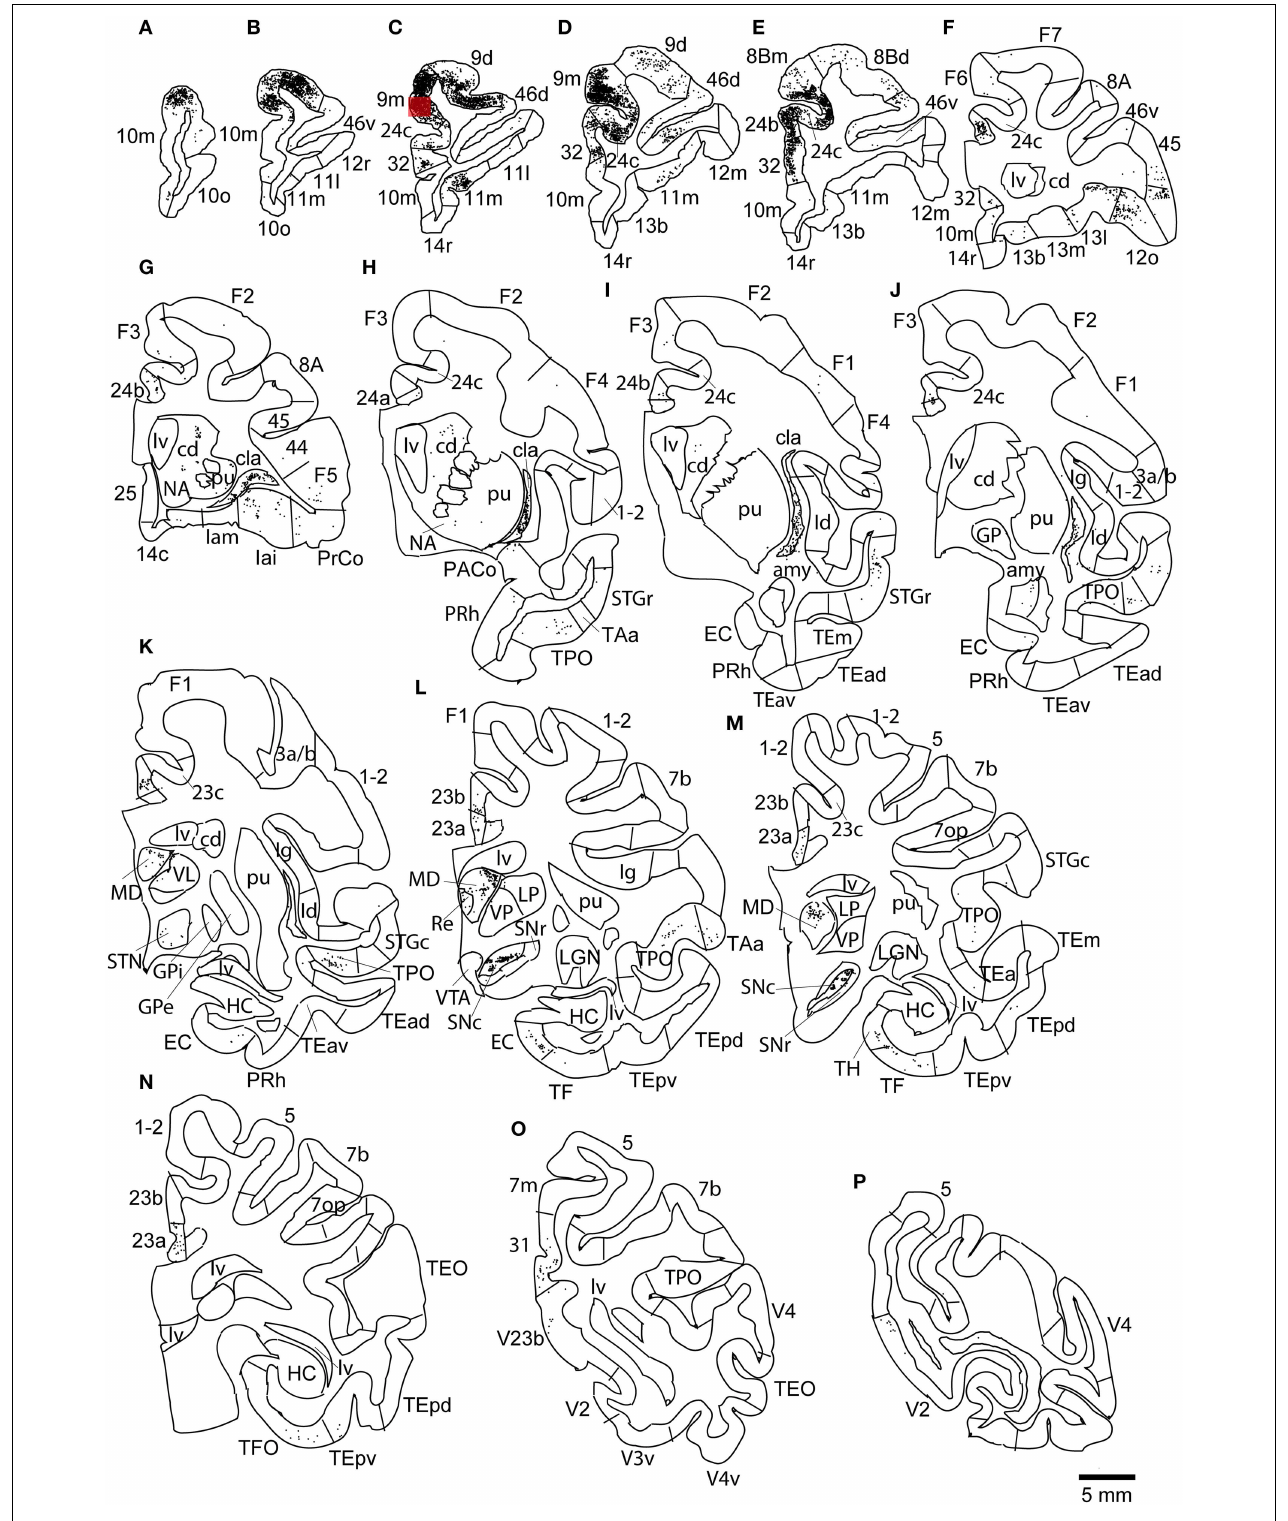
FIGURE 6 | Distribution of retrogradely labeled neurons on coronal sections in Case 2R (A–P). The abbreviations used to mark cortical areas are shown in the Abbreviations in the main text. The red square indicates the injection site.